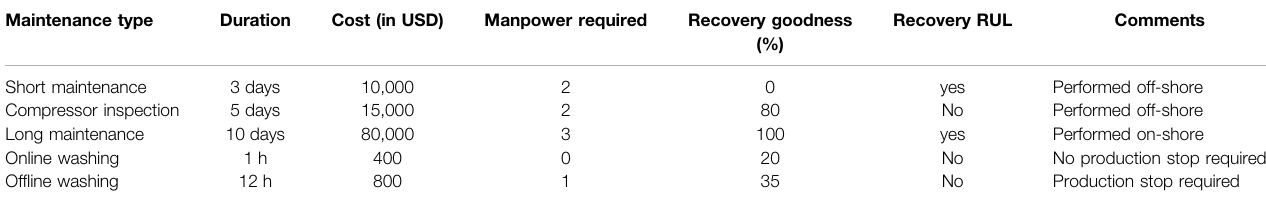
TABLE 2 | Overview of different maintenance types available in the case study. Maintenance